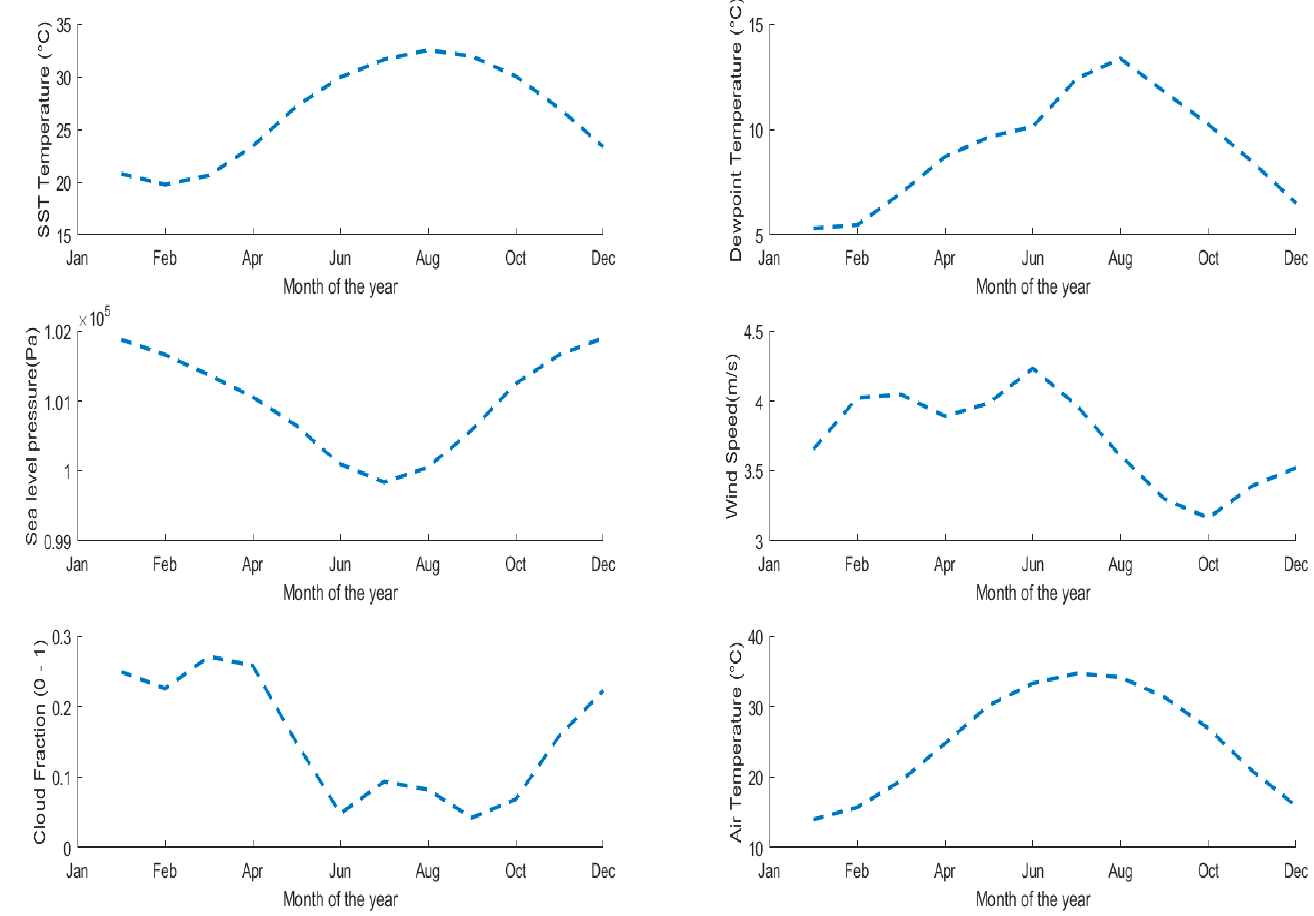
Figure 8. The seasonal variability in atmospheric parameters and surface temperature. Table 2. Monthly values of meteorological parameters.